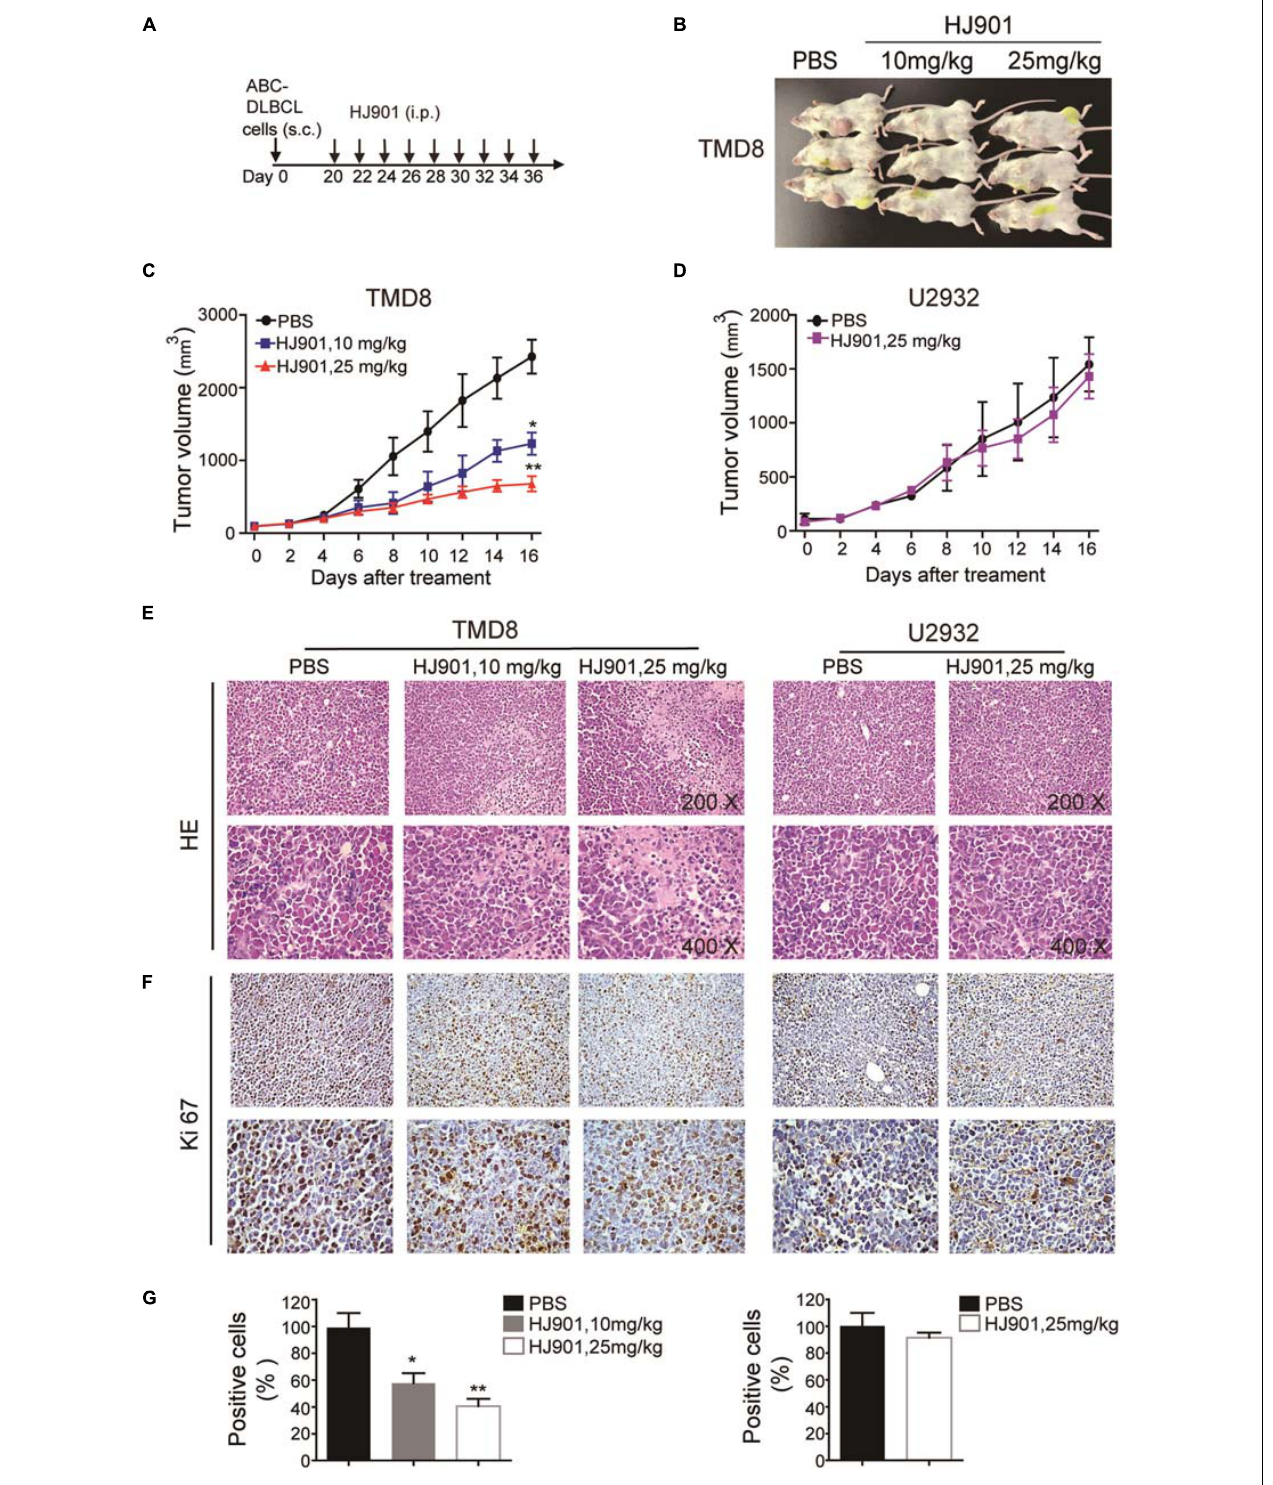
FIGURE 4 | Clampdown effect of HJ901 on cell survival and cytokine secretion in vivo . (A) Mice with TMD8 or U2932 xenografts were treated with or without HJ901 (10 or 25 mg/kg). (B) The tumor size of mice injected with TMD8 was observed at day 36. (C,D) Tumor volumes were measured every other day for 16 days. (E) Representative histological sections of the tumors were stained with hematoxylin and eosin (H&E) (magnification × 200 and 400). (F,G) Immunohistochemistry was used to detect the expression of Ki67 in tumor specimens. Similar results were obtained from three independent experiments. All data are presented as the means ± SEM ( n = 5 in each group). * p < 0.05 and ** p < 0.01 vs. PBS group.